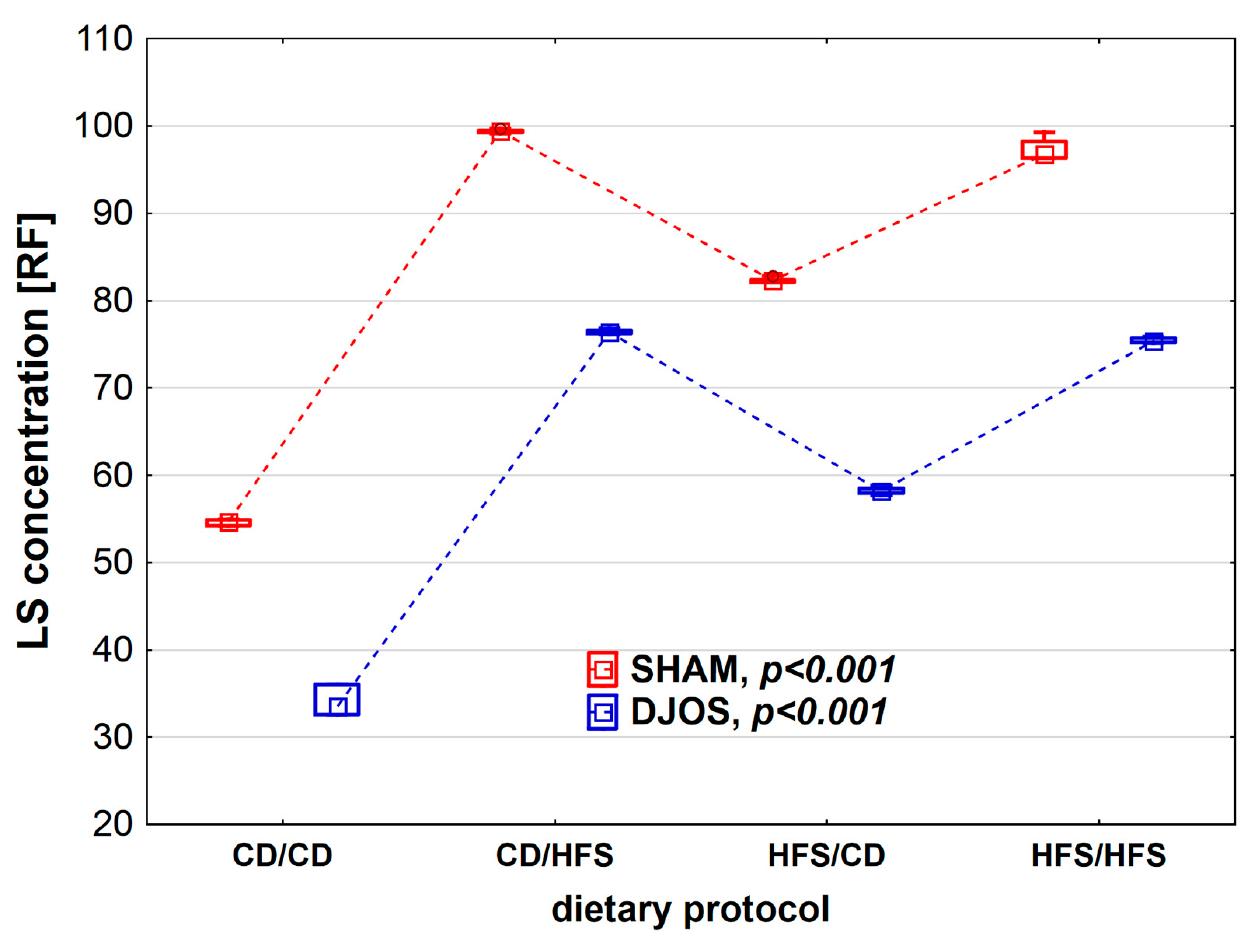
Figure 6. Lipofuscin (LS) concentration (RF) in the plasma of Sprague-Dawley rats subjected to duodenojejunal omega switch (DJOS) and control (SHAM) surgery and different dietary protocols at 8 weeks after the surgery. Legend: CD—control diet, HFS—high-fat/high-sugar diet, RF—relative lipid extract fluorescence. The inner boxes represent the medians, the outer boxes represent interquartile ranges, and whiskers represent min–max range. For the reader’s convenience, the medians are connected with dashed lines.